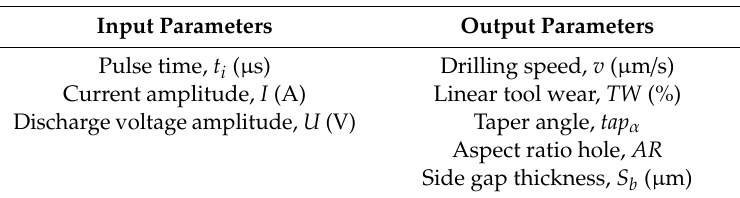
Table 4. Process parameters and their levels.